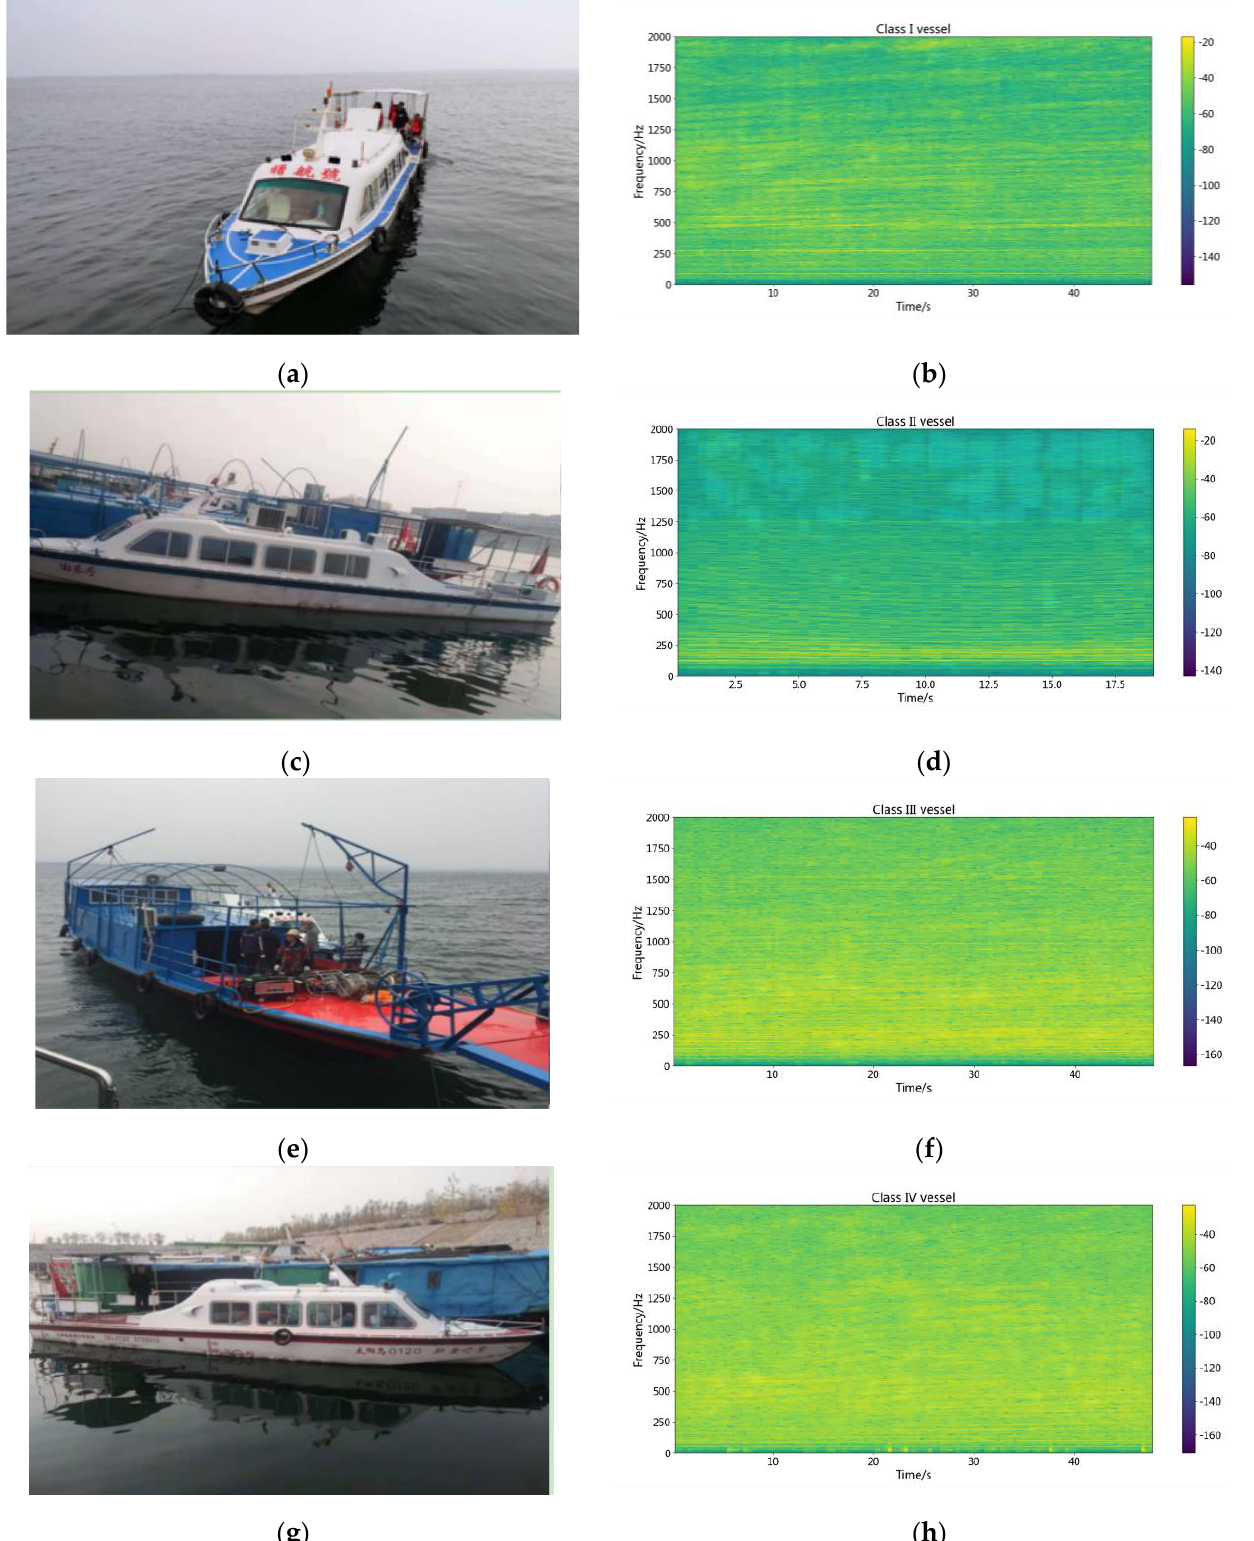
Figure 6. The pictures and spectrograms of the different vessels. ( a ) the pictures of class I vessel. ( b ) the spectrogram of class I vessel. ( c ) the pictures of class II vessel. ( d ) the spectrogram of class II vessel. ( e ) the pictures of class III vessel. ( f ) the spectrogram of class III vessel. ( g ) the pictures of class IV vessel. ( h ) the spectrogram of class IV vessel.